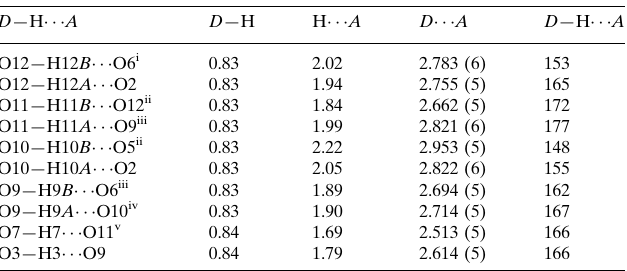
Hydrogen-bond geometry (A˚ , (cid:2)